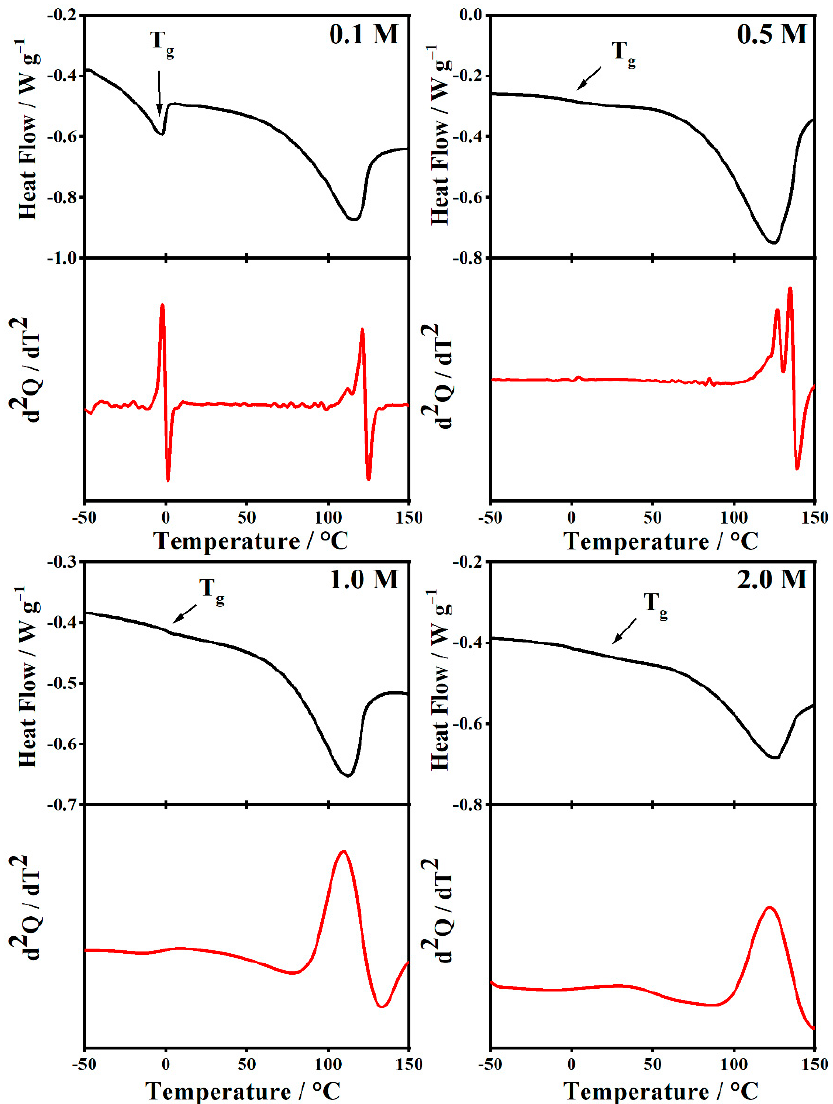
Figure 19. The Differential Scanning Calorimetry (DSC) curve (black solid curve) and the second derivative of the respective DSC signal (red dot curve) were collected during a heating process with a rate of 10 °C/min on PMMA-Li-PC-EC gel polymer electrolyte at different salt concentrations: 0.1 M, 0.5 M, 1 M and 2 M.